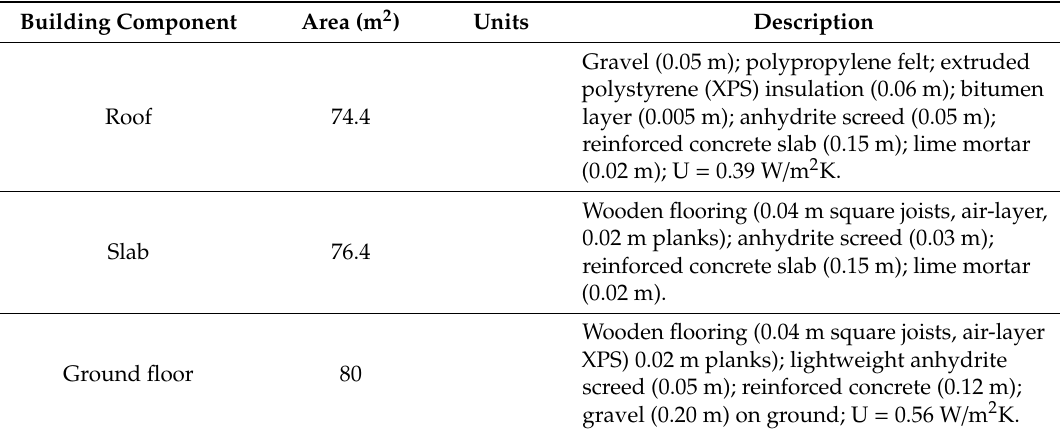
Table 2. Base case house building components